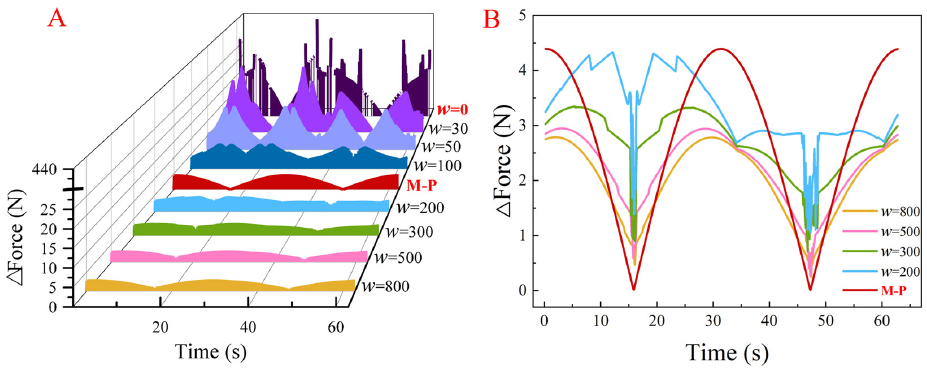
Figure 11. Driving force mutation of MCPM ( M = 2, N = 2) using different optimization methods: ( A ) overall 3D view and ( B ) comparison of the M ‐ P method and improved method in 2D view.